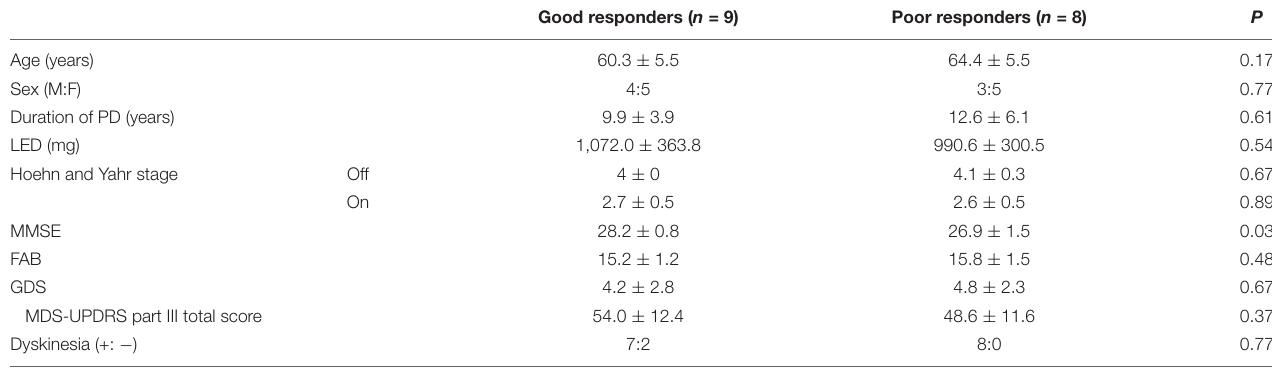
TABLE 1 | Comparison of each item at baseline between good responders (changes of Movement Disorder Society-Unified Parkinson’s Disease Rating Scale (MDS-UPDRS) part III total score after surgery (cid:61) 50%) and poor responders ( < 50%). Good responders ( n =